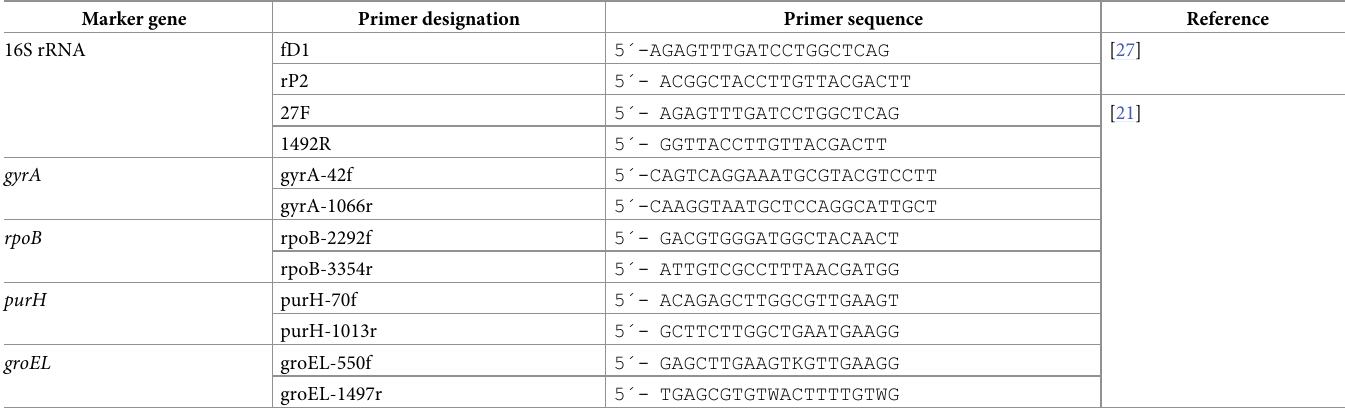
Table 2. PCR primers used in this study. Marker